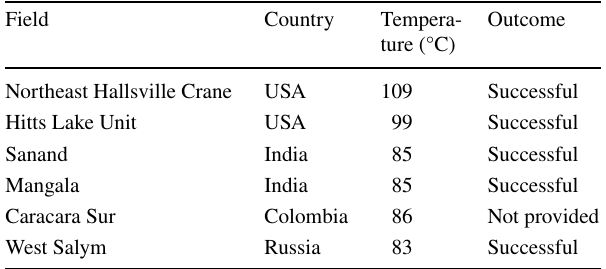
Table 1 HPAM pilot test in high temperature conditions